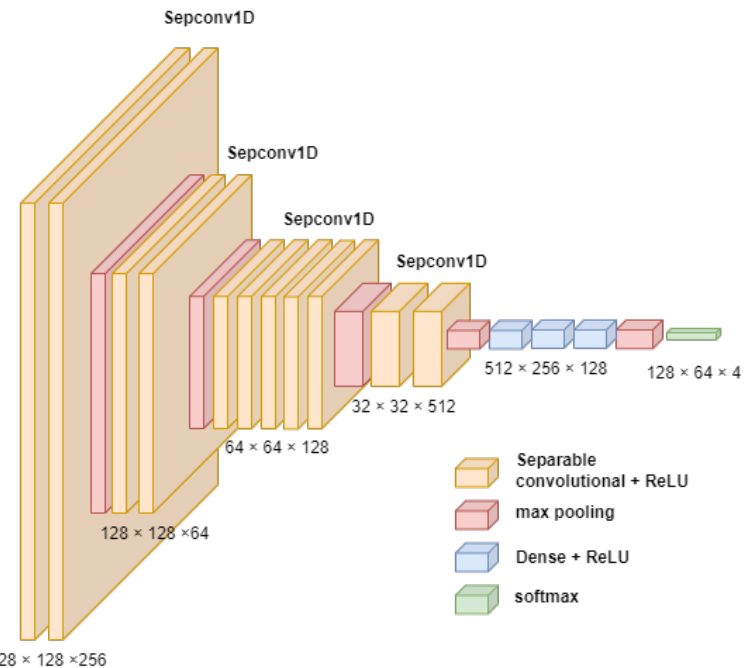
Figure 8. The EEG neural network architecture. The basis for this configuration is presented in